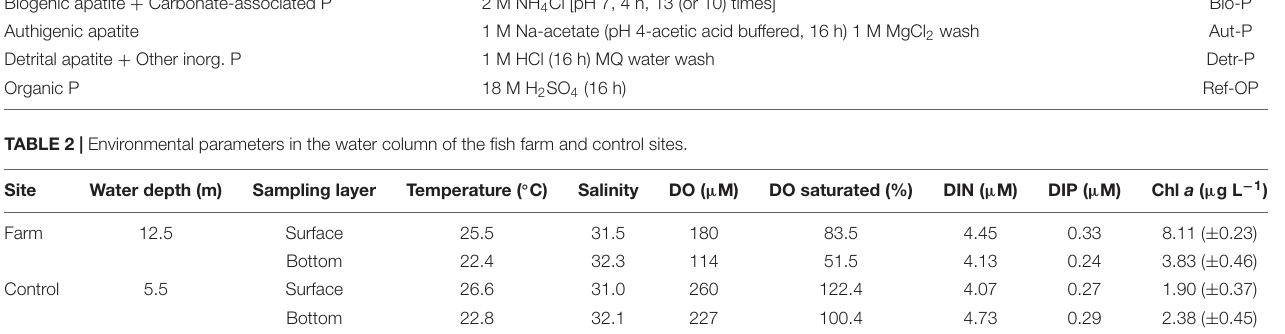
( Table 4 ). Overall, dissolved and solid-phase constituent